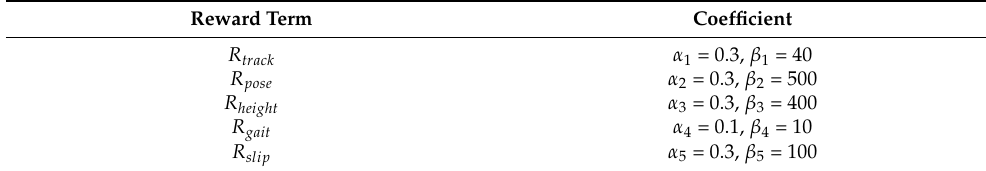
Table A2. Reward design and parameters.